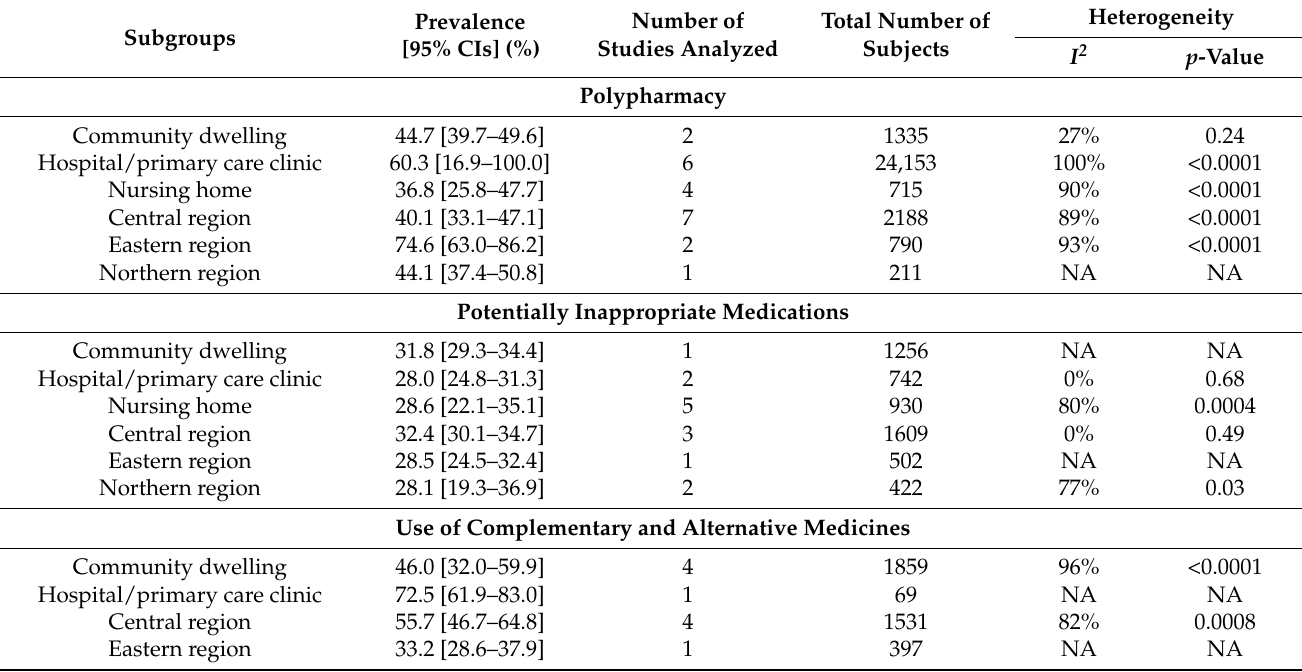
Table 2. Pooled prevalence of drug-related problems in different subgroups of elderly subjects.